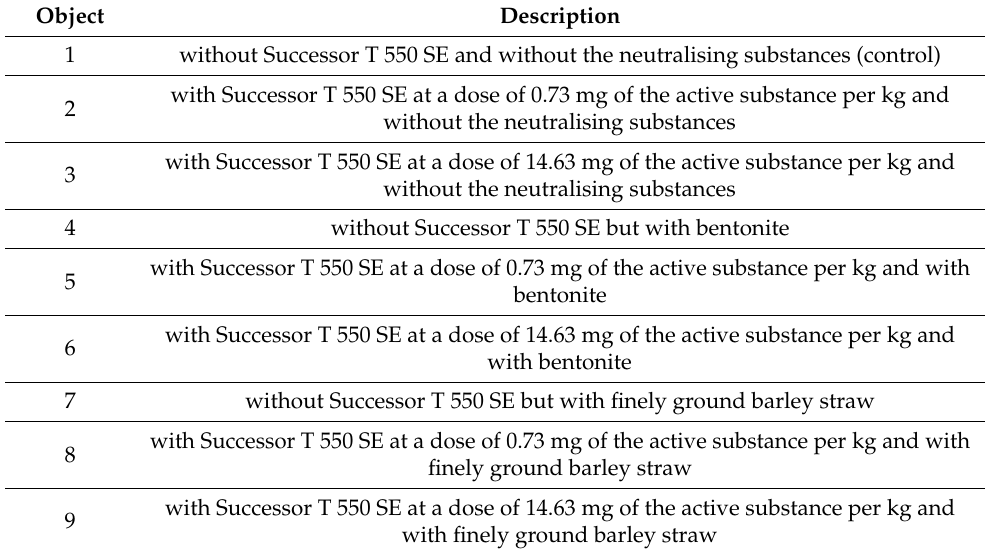
Table 1. Combinations used in the